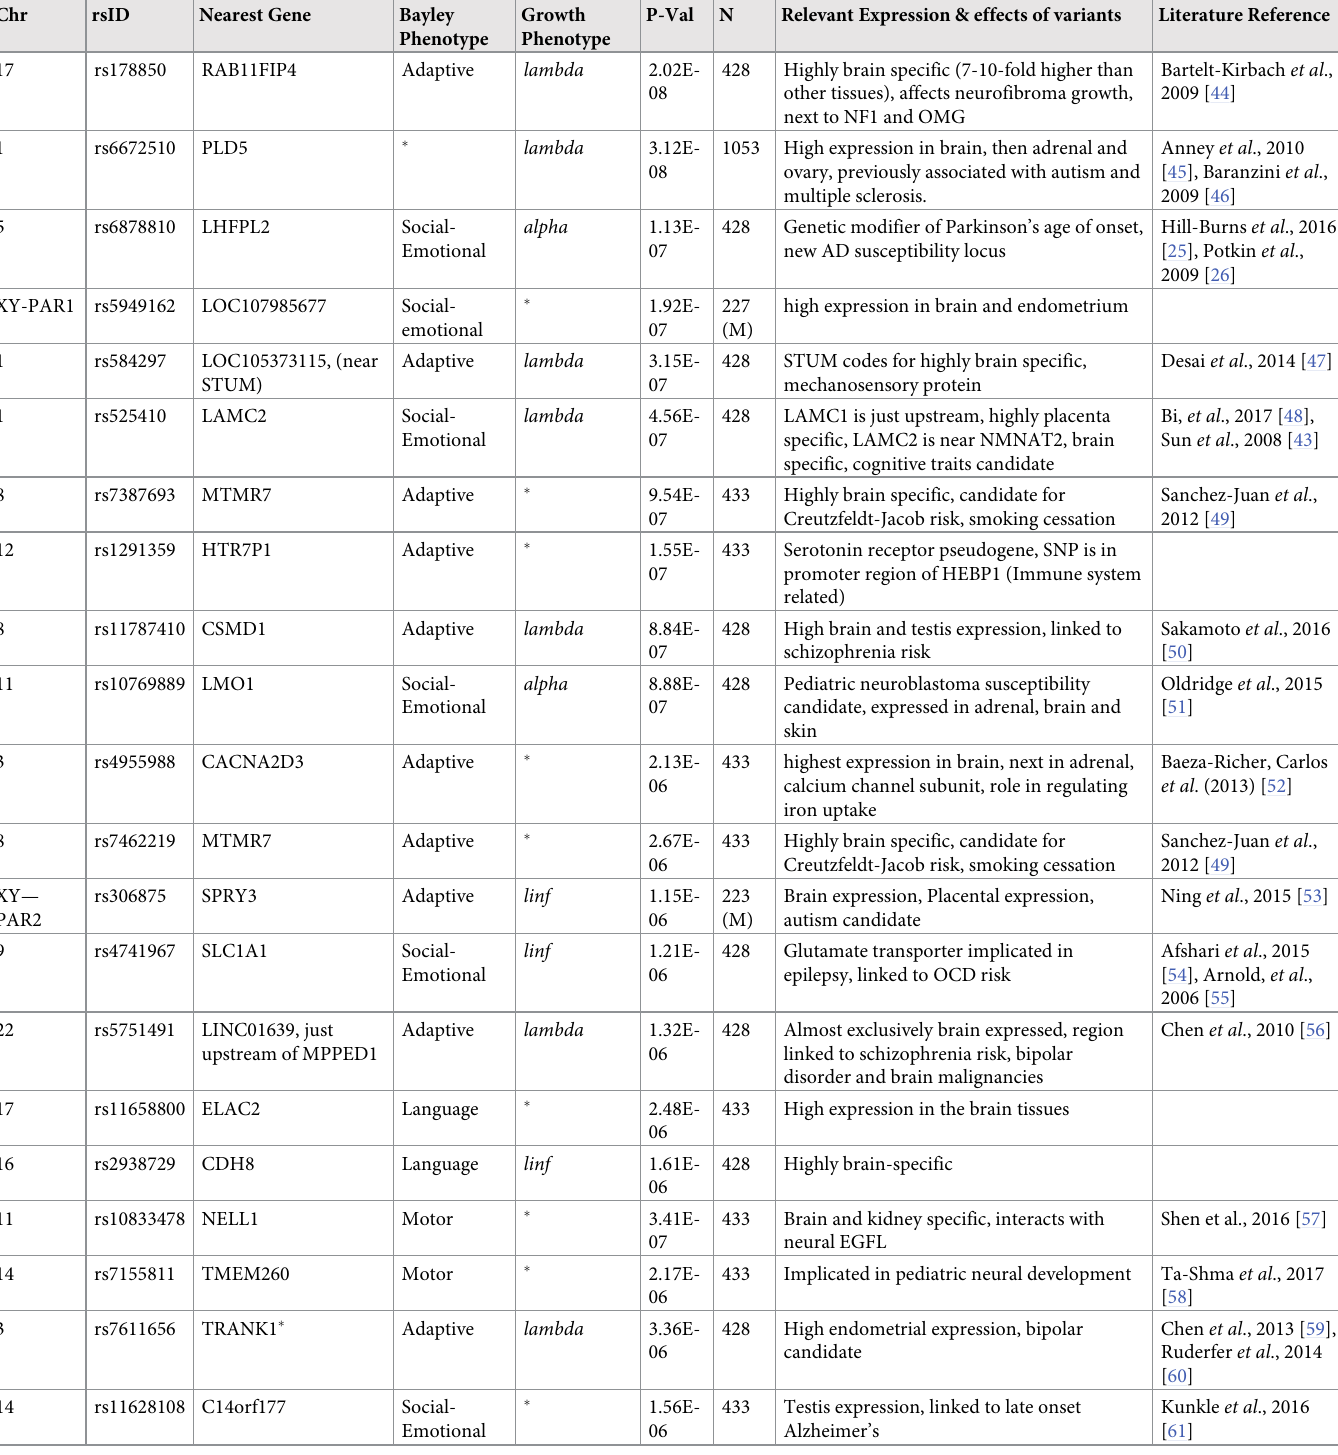
Table 8. Summary of neurological development